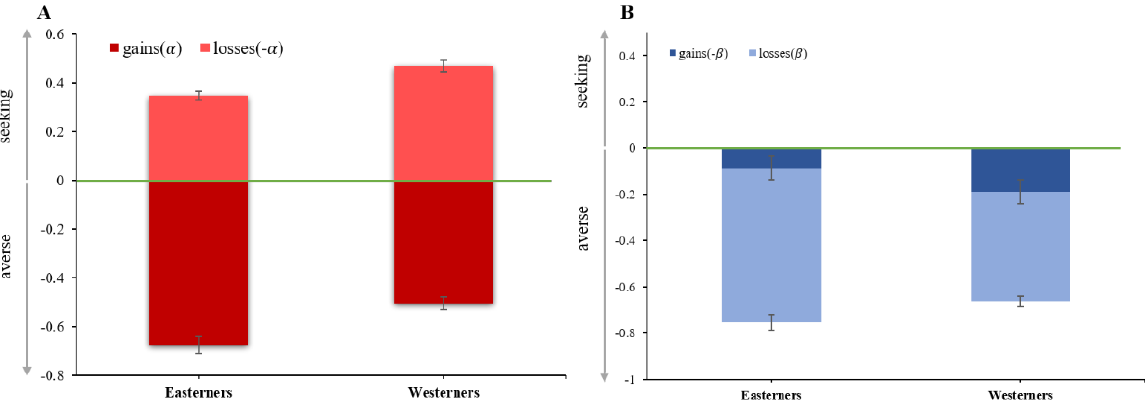
Figure 5. Estimated ( A ) risk and ( B ) ambiguity in the gain and loss domains. The green lines denote risk neutrality ( α = 0) in A and ambiguity neutrality ( β = 0) in B .